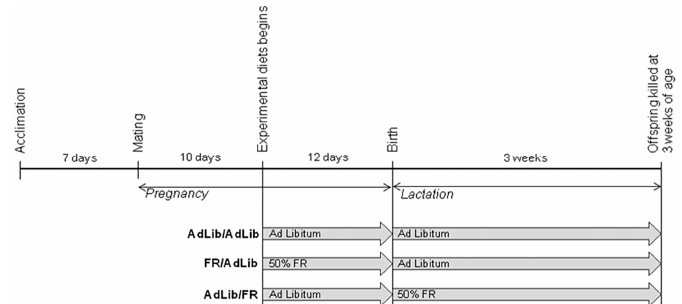
Figure 1. Experimental design. Eight-week-old male and female Sprague-Dawley rats were used in this study. After a one-week acclimation period, the animals were mated. At day 10 of gestation, female rats were divided randomly into three groups: (1) AdLib/AdLib, provided an ad libitum (AdLib, control) diet throughout the experimental period; (2) FR/AdLib, provided a 50% food-restricted